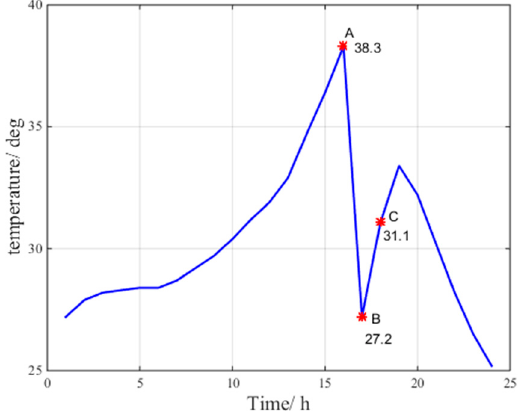
Figure 6. Abnormal temperature condition.